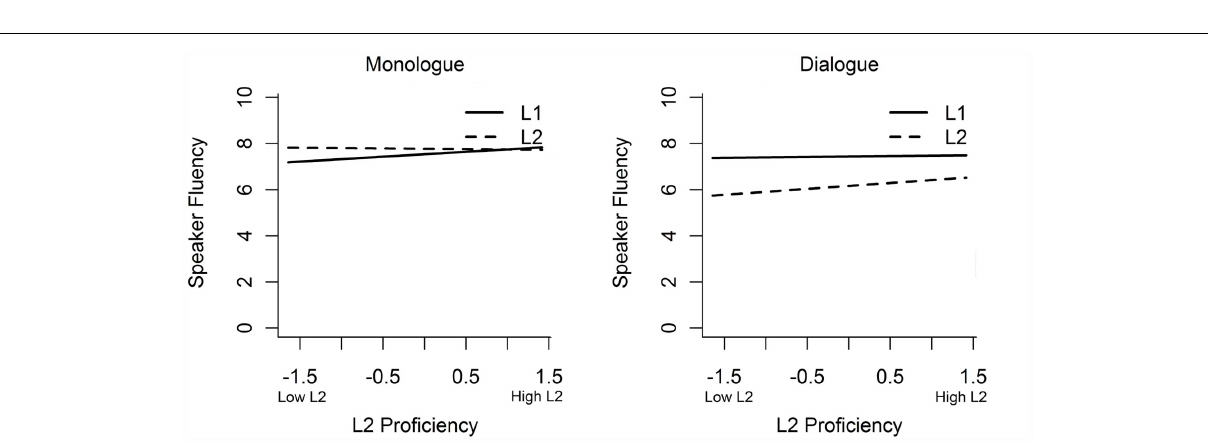
FIGURE 3 | Graphical representation of partialed effects from model fits of L2 proficiency on the clarity of instructions in L1 and in L2 across monologues (left panel) and dialogues (right panel). Clarity of instructions was significantly lower in L2 vs. L1 for low L2 proficient bilinguals in monologues. Clarity of instructions was not different for high L2 proficient bilinguals in monologues and for bilinguals of all L2 proficiency levels in dialogues.